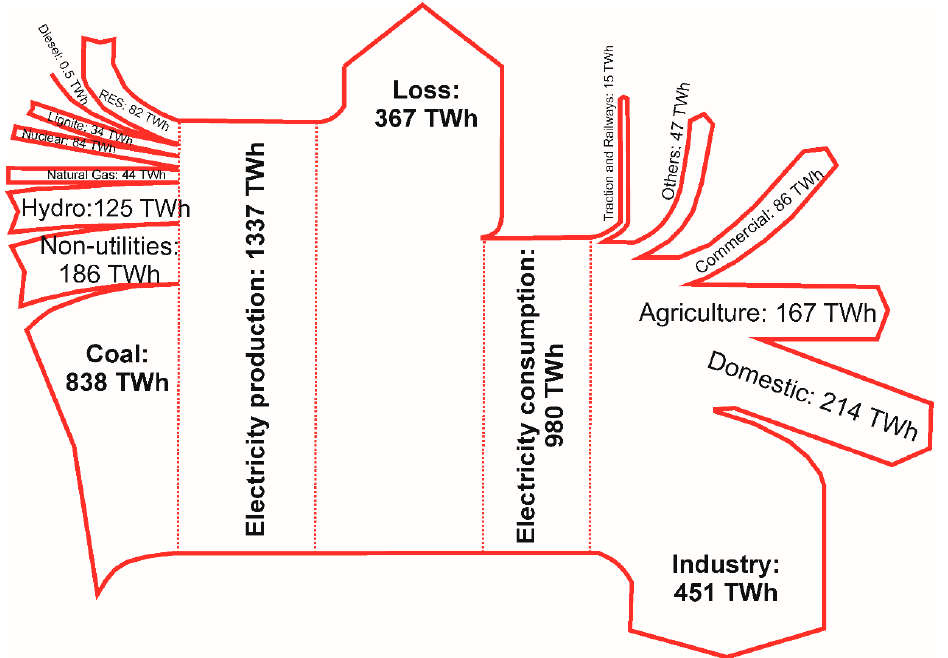
Figure 3. Electricity production and consumption in India in 2015.